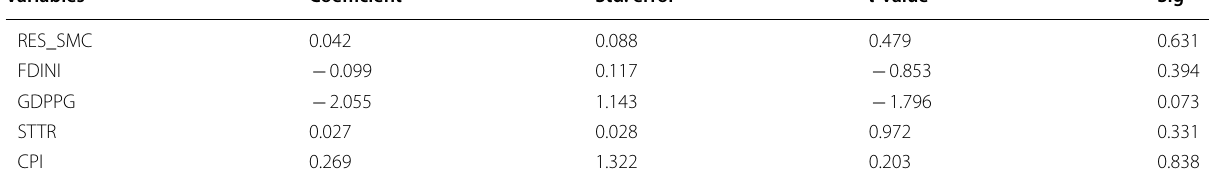
Table 8 Endogeneity test. Source: Software of E-views 10 output. The dependent variable is the DCF. Method: Panel Least Squares